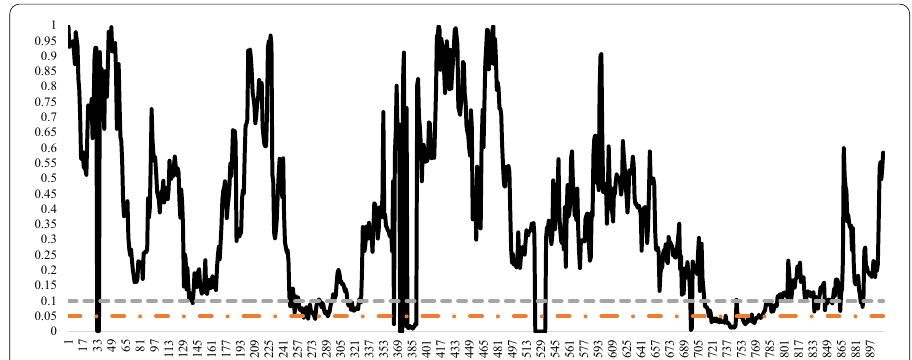
Fig. 15 The evolving p values of the AQ test statistic checked for the Gold in 100-day window length